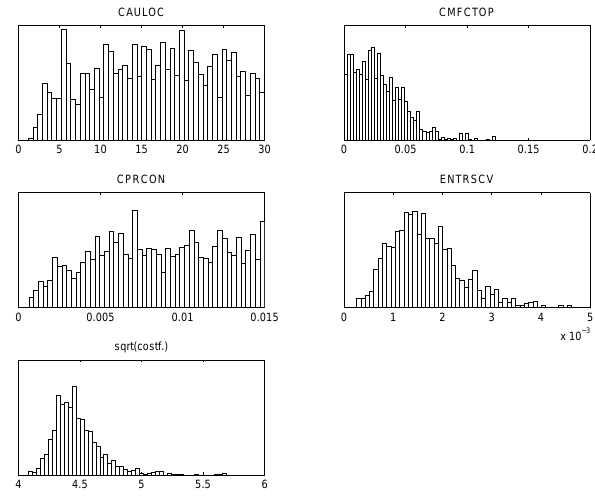
Fig. 4. Estimated posterior distributions as chain histograms for the J G + ZONAL cost function. Histogram is calculated from the chain with the first 1000 values removed. The lowest panel shows the histogram of square root of values of the cost